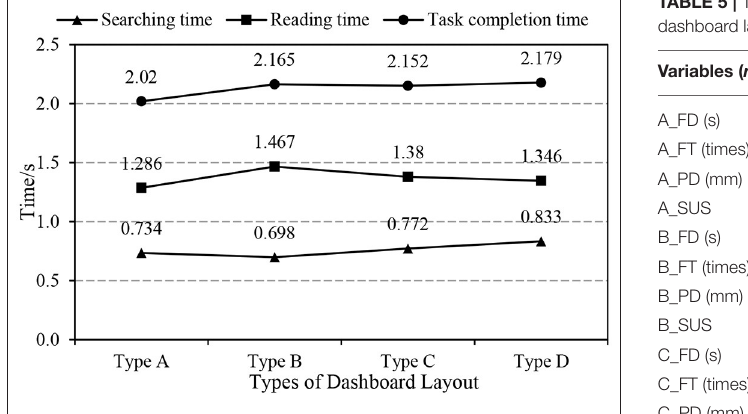
FIGURE 6 | Dashboard reading task completion time vs layouts.